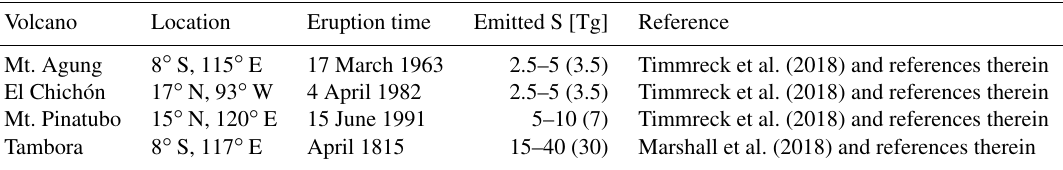
Table 1. List of tropical volcanic eruptions with location, eruption date and estimated amount of emitted sulfur. The sulfur amounts in parentheses represent the best